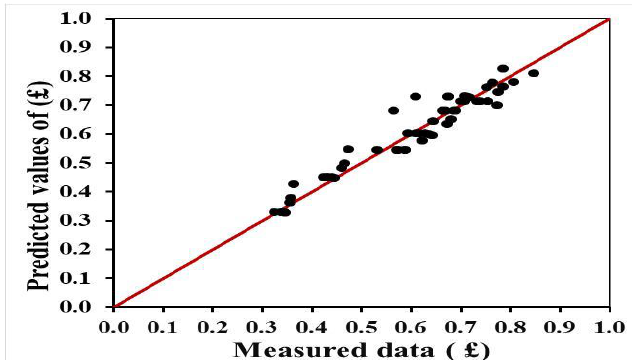
Figure 16. Measured £ versus predicted values from Equation (2).